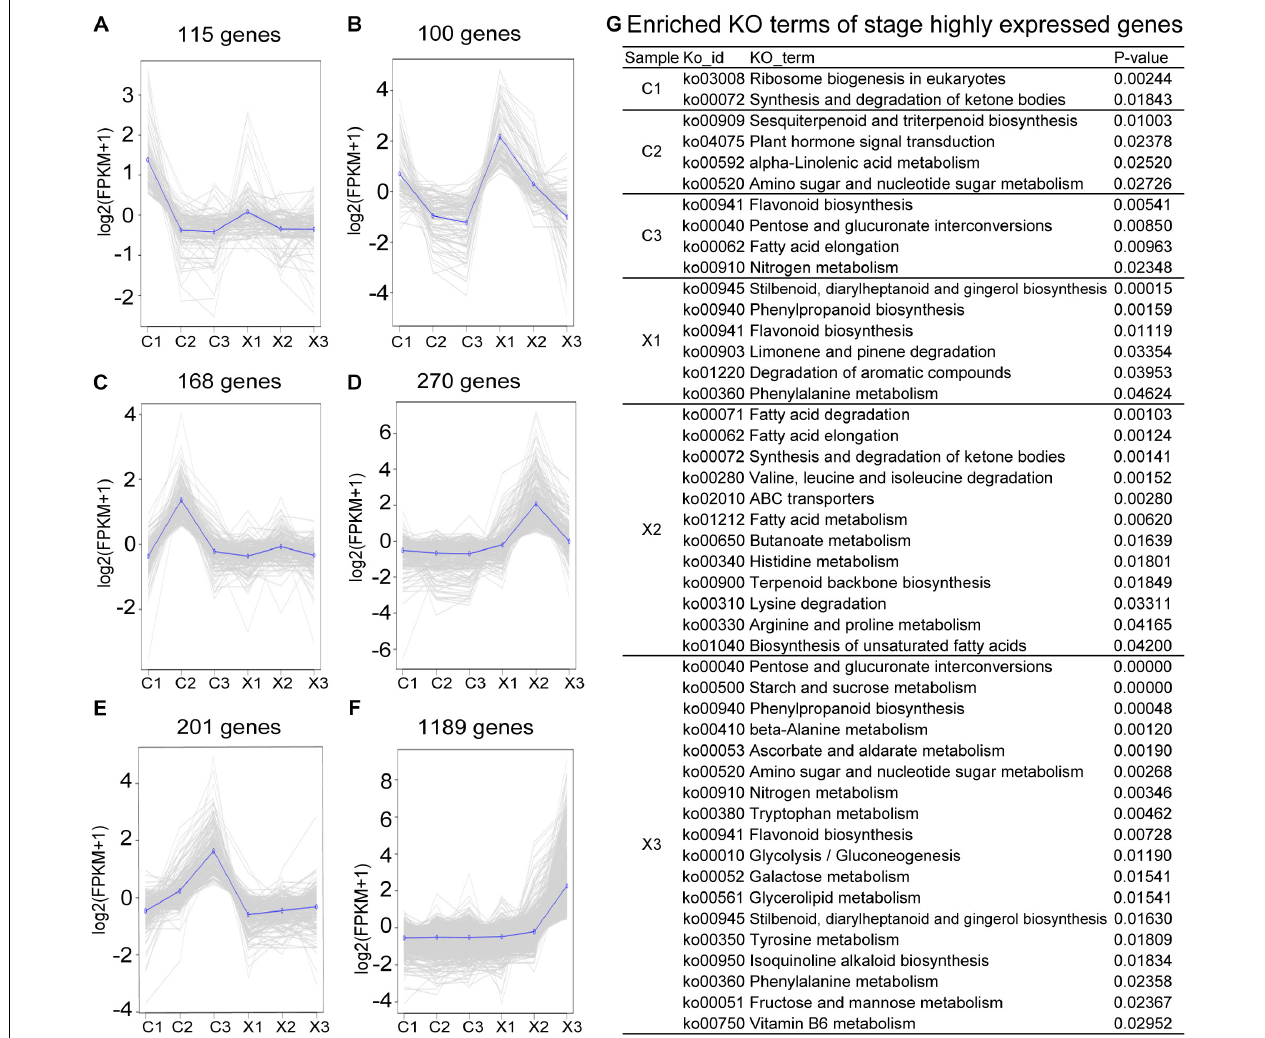
FIGURE 3 | Analysis of stage-specific genes in male and female flowers. (A–F) Expression patterns of specific genes to each developmental stage of female flowers, with the average expression trend highlighted. (G) Enriched KO terms among stage-specific genes ( p -values ≤ 0.05).